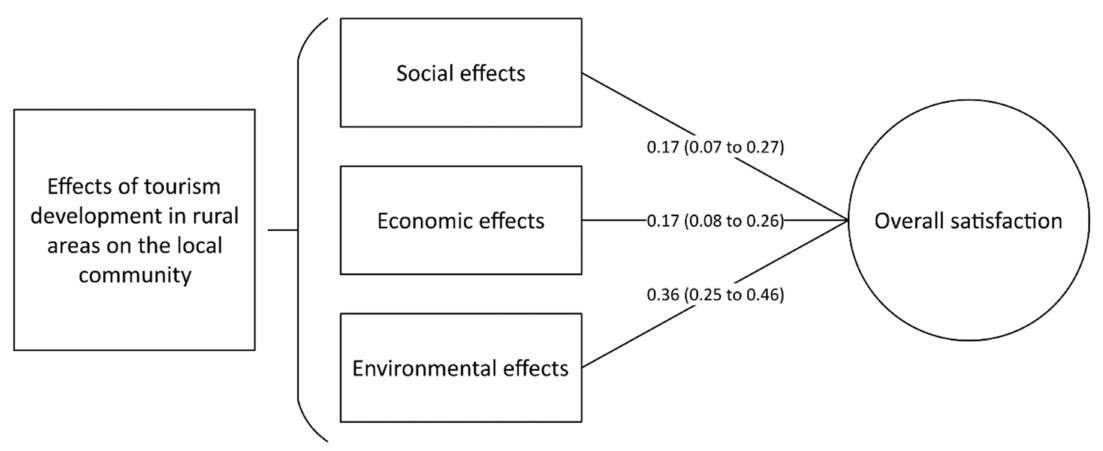
Figure 4. Results of the multivariate regression analysis regarding the impact of different tourism development domains on the overall satisfaction of residents in the rural regions in Al-Ahsa.